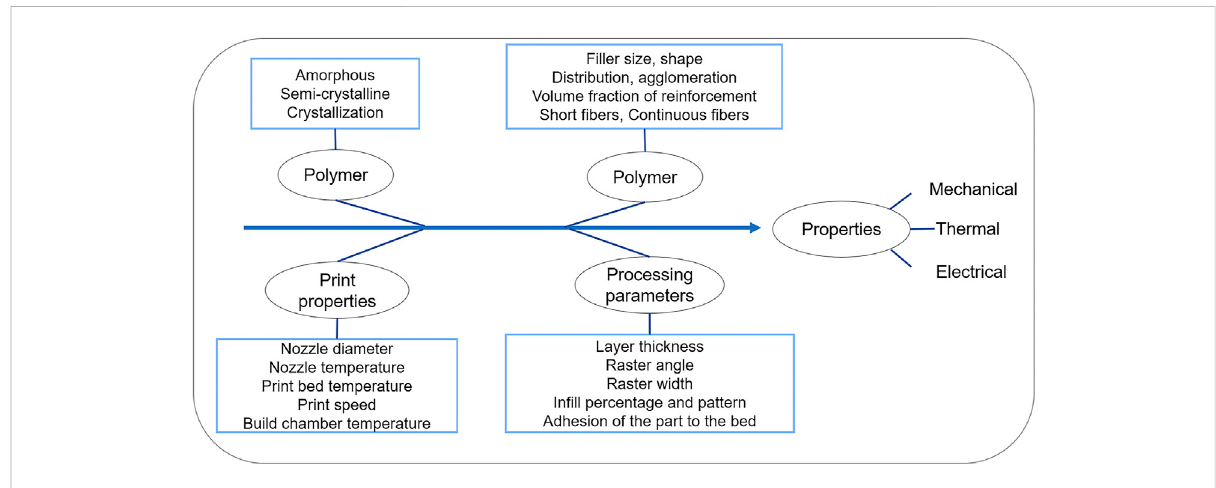
FIGURE 3 Several factors that in fl uence the characteristics of FFF printed